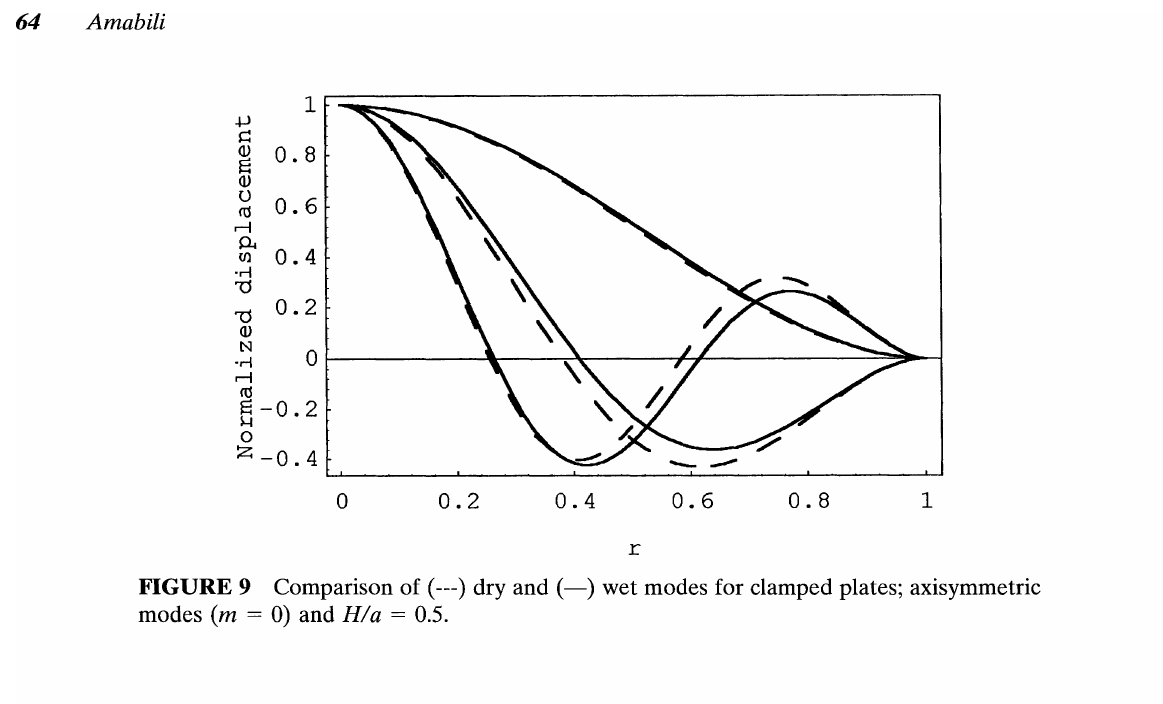
FIGURE 9 Comparison of (---) dry and (-) wet modes for clamped plates; axisymmetric modes (m = 0) and H/a = 0.5.